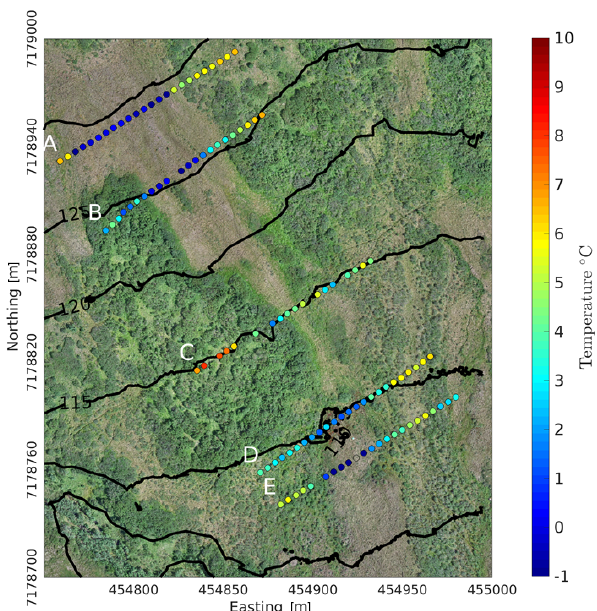
Figure 2. Temperatures at 0.8m depth extracted from the DTP dataset collected on 17 July and topographic isolines for every 5m of elevation (in